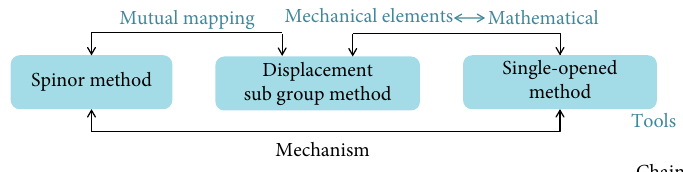
Figure 3: Relationship between three type synthesis methods.